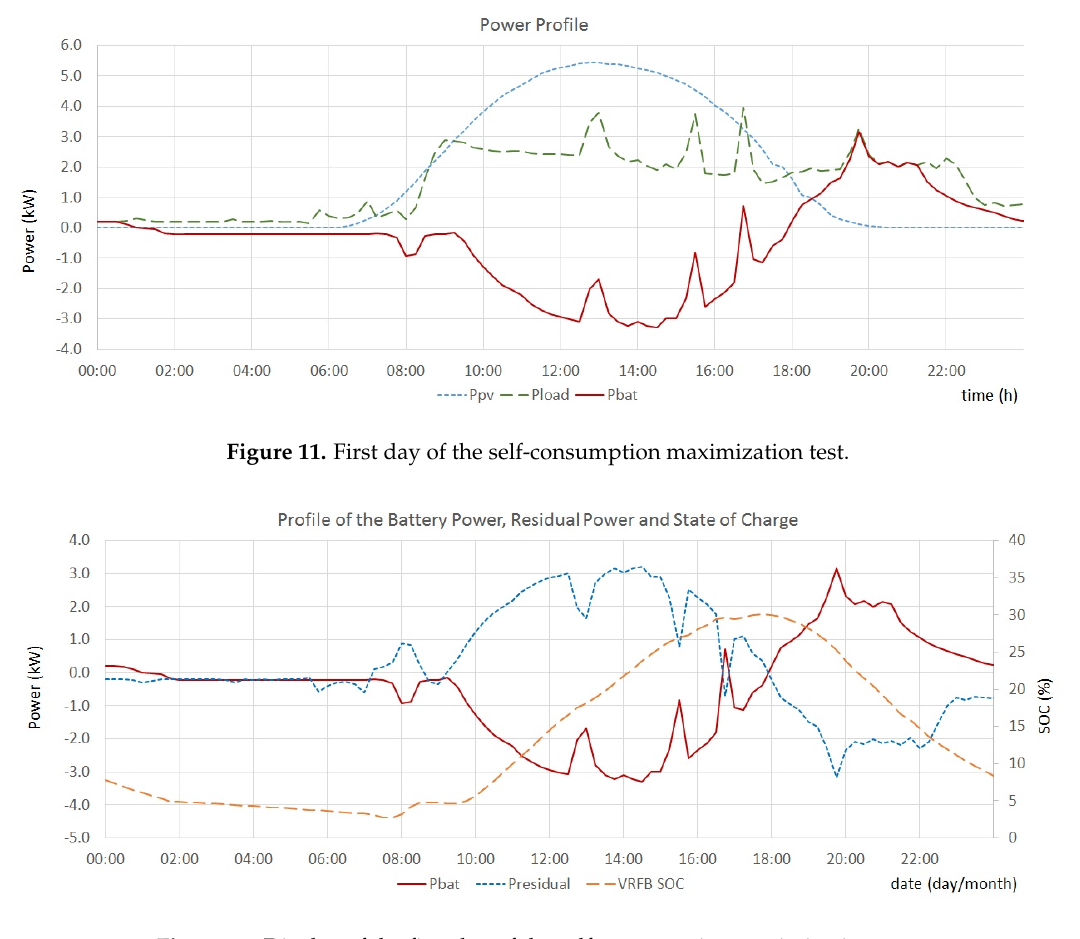
Figure 12. Display of the first day of the self-consumption maximization